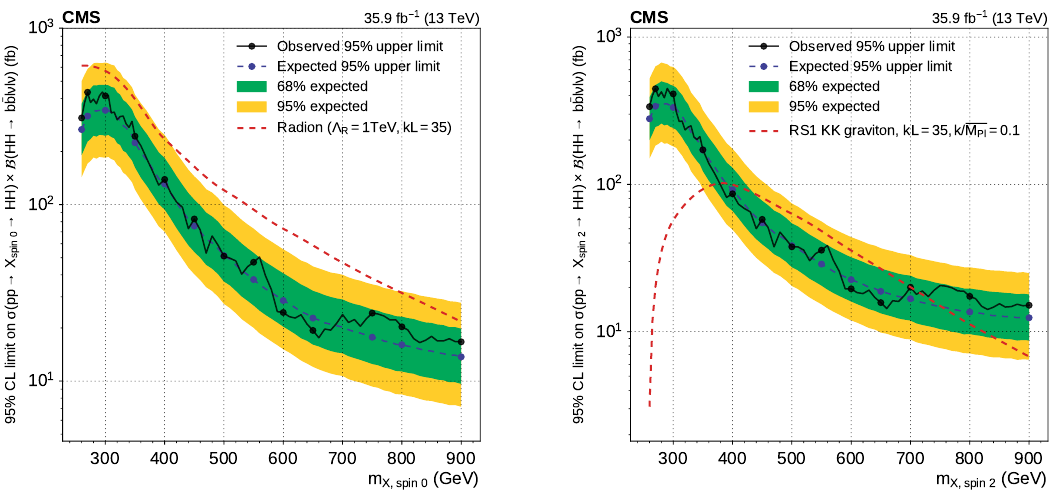
e (cid:6) (cid:22) (cid:7) channels. The observed upper limit on the SM HH ! bbVV ! bb ‘(cid:23)‘(cid:23) cross